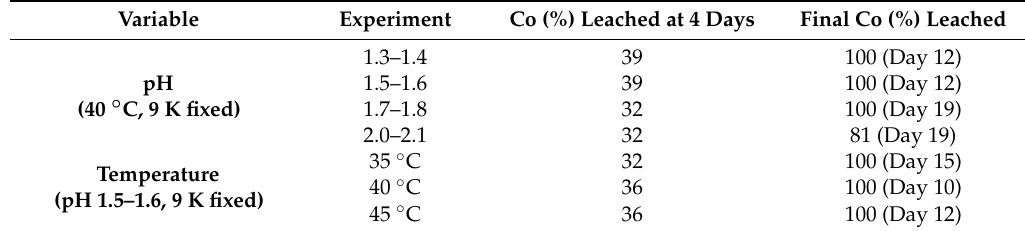
Table 4. Percentage of Co leached per experiment after 4 days and at the batch experiment